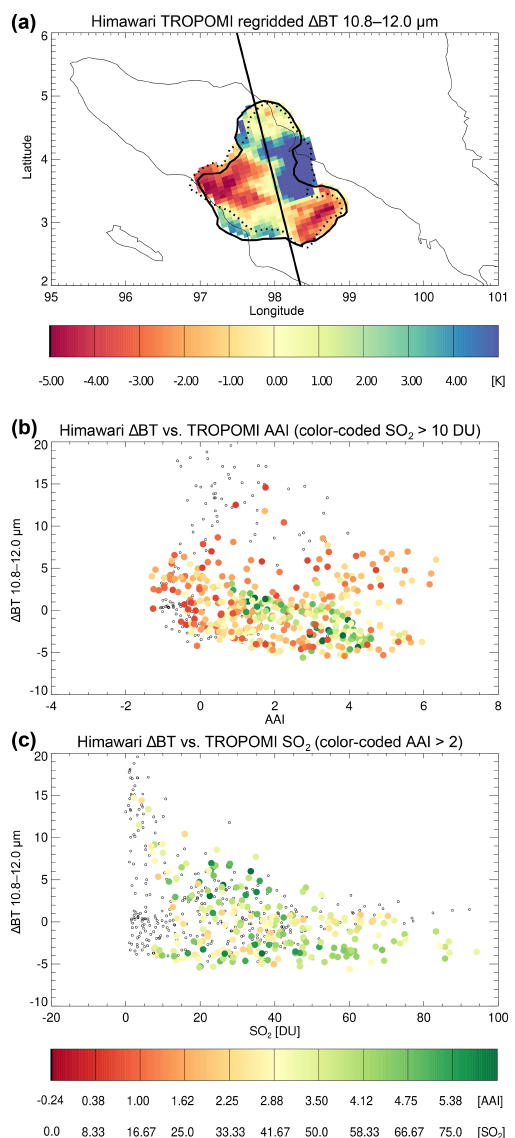
Figure 5. (a) Himawari-8 (cid:49) BTs for 19 February 2018 at 06:30UTC (see also Fig. 4) regridded to the TROPOMI measurement grid of that day, and correlations between the Himawari-8 (cid:49) BTs and TROPOMI (b) AAI and (c) SO 2 . The solid and dotted contours de- note outline of TROPOMI>10DU SO 2 columns and TROPOMI AAI>0 value, as also shown in Fig. 4 and in Fig. 1. The color- coding of the dots in the AAI scatterplots is indicative of the cor- responding SO 2 value (>10DU), and the color-coding in the SO 2 scatterplot is indicative of the AAI value (AAI>2); see also the lower color bar. These color-codings were added for qualitatively identifying possible relationships between (cid:49) BT and AAI or SO 2 within the volcanic ash